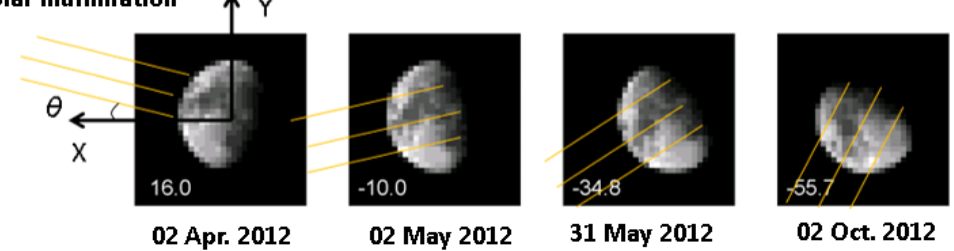
Figure 5. The definition of the solar illumination angle in FPA coordinates. The number at the bottom left corner of each plot is the angle for that